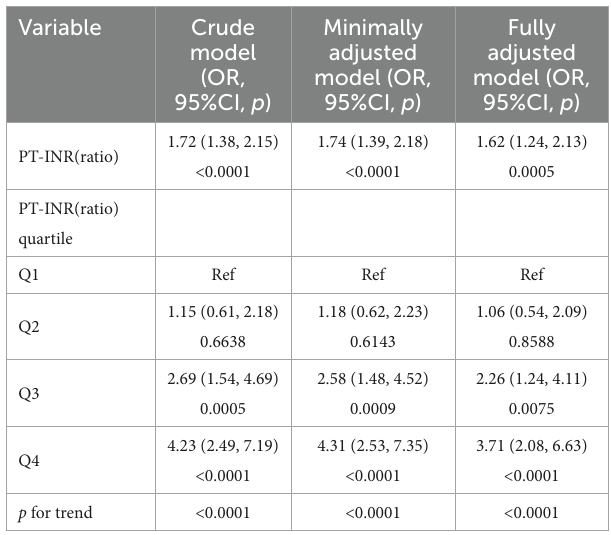
TABLE 3 The results of multivariate analysis using nonadjusted and adjusted Cox regression models.